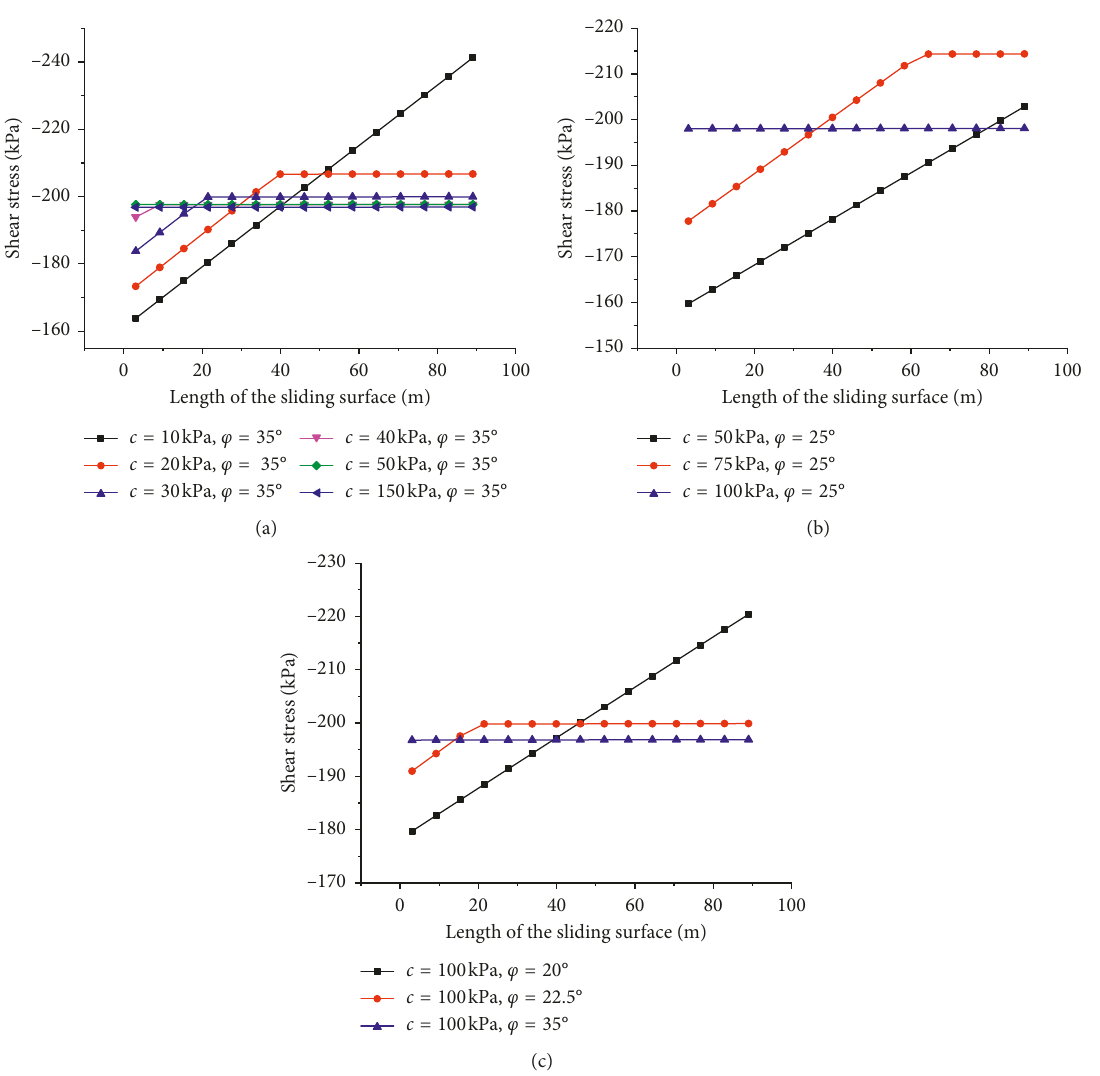
35 ° , with the change in value of c ; (b) φ (cid:31)